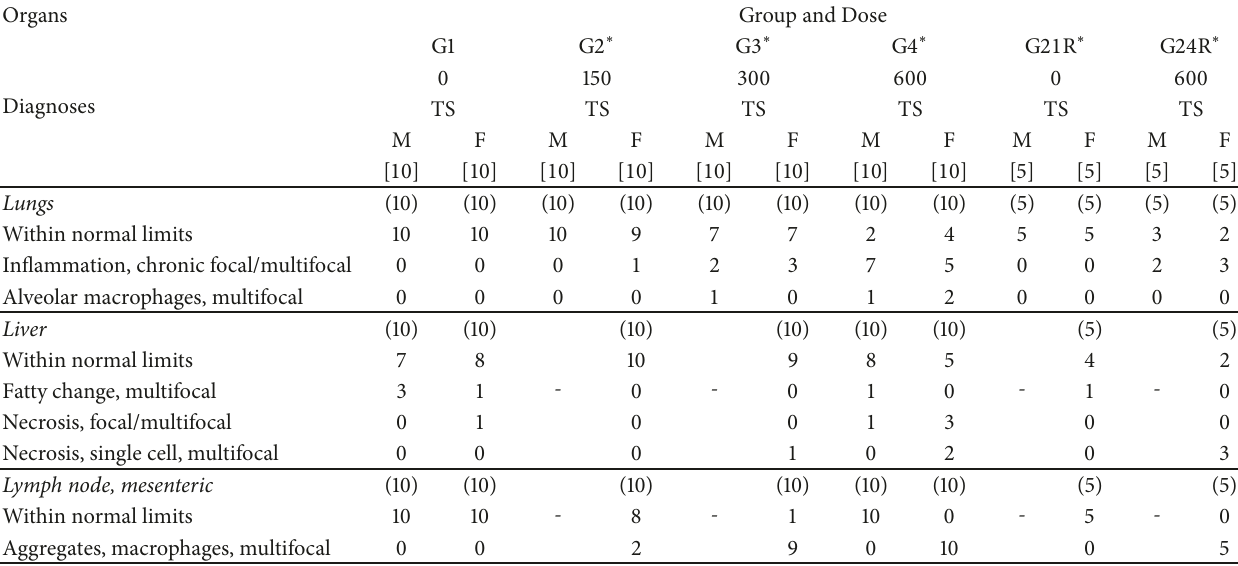
Table 14: Summary of histopathological examination, males and